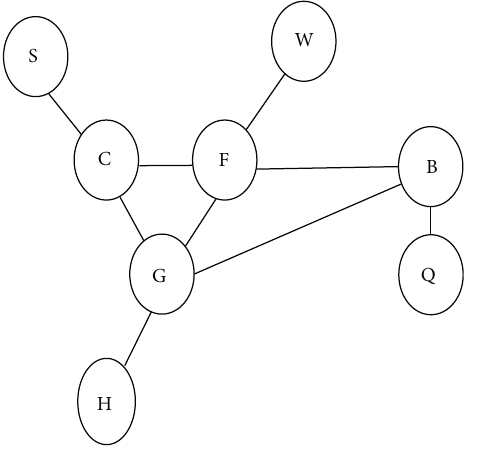
Figure 1: Triangulated Moral diagram.